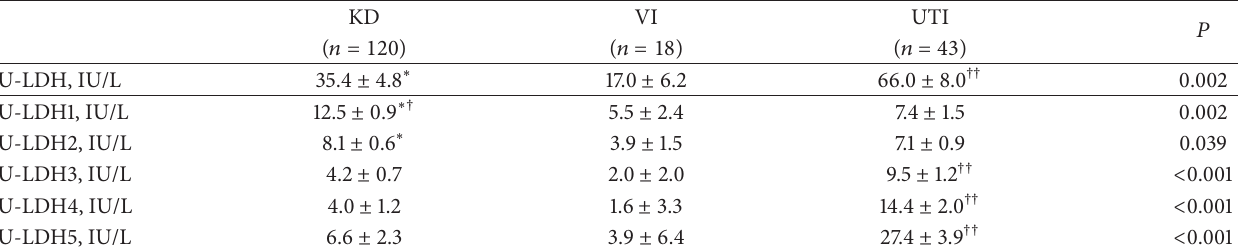
Table 2: A comparison of U-LDH and its isozyme patterns among KD, VI, and UTI groups.